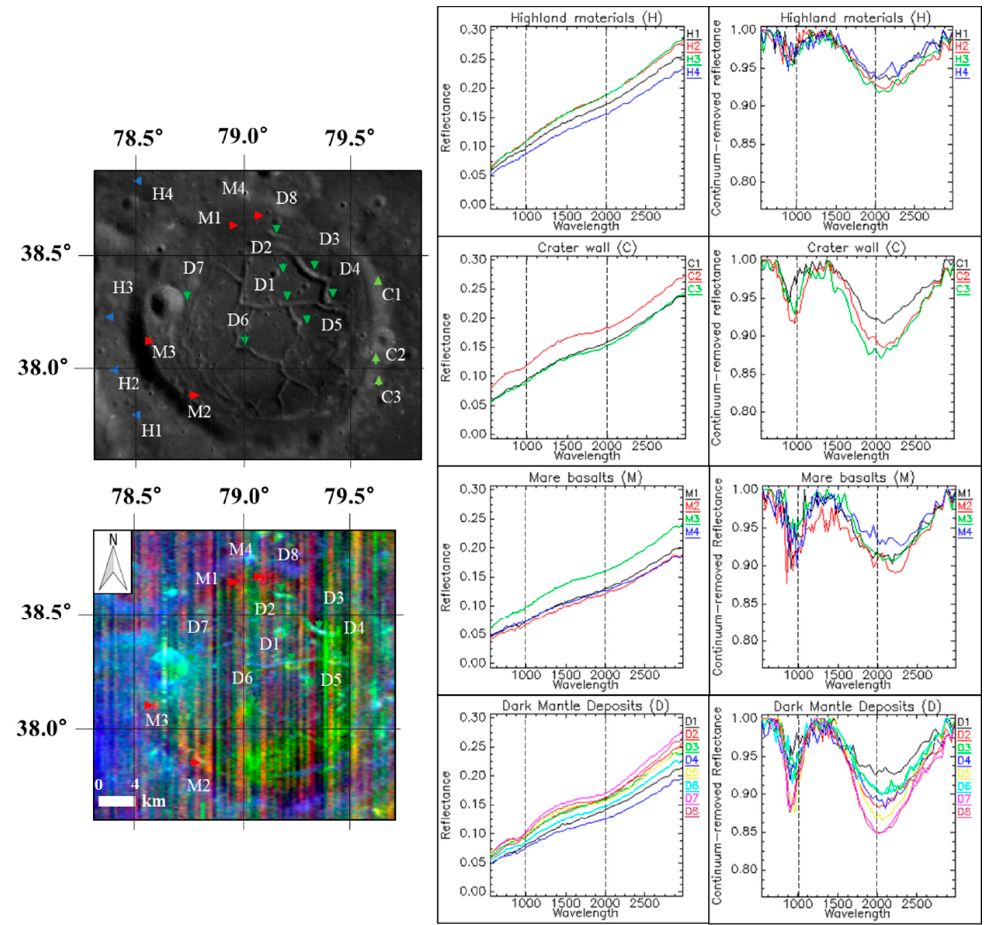
(C1–C3), mare basalts (M1–M4), and dark mantle deposits (D1–D8). The WAC base map was taken from https://quickmap.lroc.asu.edu, accessed on 1 April 2022. To the right, the corresponding reflectance spectra and continuum-removed spectra are shown. The dashed lines in the spectra indicate the wavelengths of 1000 nm and 2000 nm. On the lower left, the RGB composite derived from the M 3 level 2 data is shown.